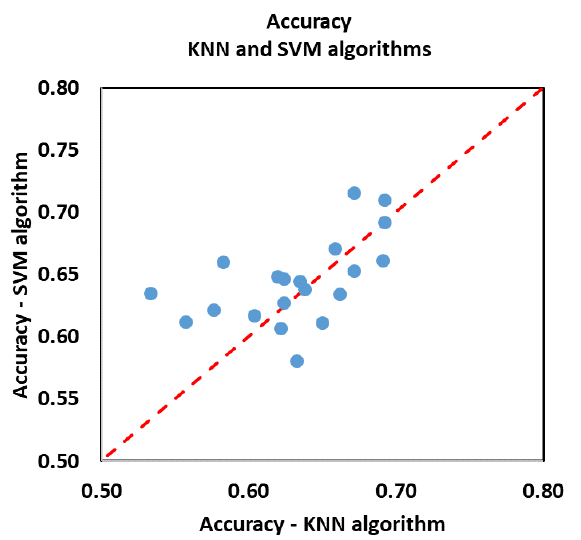
Figure 11. Accuracy values. Each point represents the accuracy with which one of the five emotional variables was classified, having used one of the four sets of features.